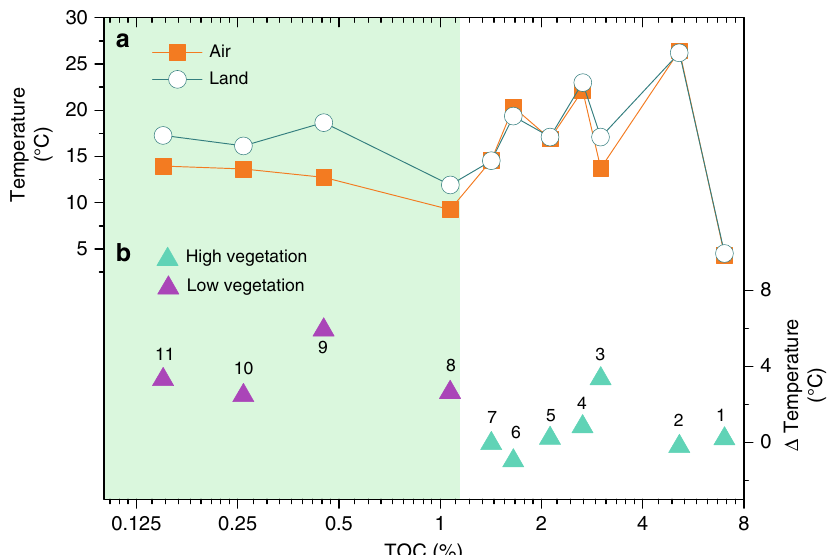
Fig. 2 Measured land surface and air temperatures in bacterial growth seasons and the temperature difference against total organic carbon (TOC) contents at 11 locations in China. a Measured in situ land surface and air temperatures. b Temperature difference between measured in situ land surface and air temperatures. (1) Aershan, (2) Haikou, (3) Yijun, (4) Guilin, (5) Manchuanguan, (6) Taoyuan, (7) Luochuan, (8) Baiyunebo, (9) Wuyuan, (10) Yulin and (11) Dengkou. TOC content is used here to indicate vegetation cover. Bacterial growth seasons are de fi ned as the period from March to November. The purple triangles represent the locations with low vegetation biomass, while green triangles represent the locations with high vegetation biomass. The highlighted low TOC ( ≤ 1.2%) interval indicates high temperature contrast in little vegetated regions. See Supplementary Fig. 2 for